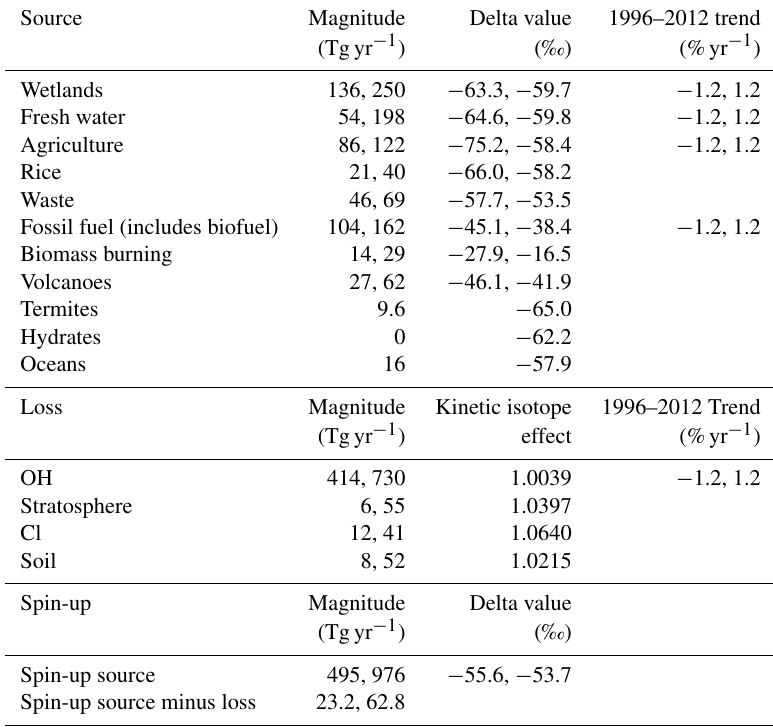
Table 2. A table of the ranges of the 28 input parameters to MOZART that were varied in the training simulations, hence also in the emulators, and in the sensitivity analysis. Where one value is given, the value is held constant for all training simulations. Where two values are given, they are the lower and upper limit,